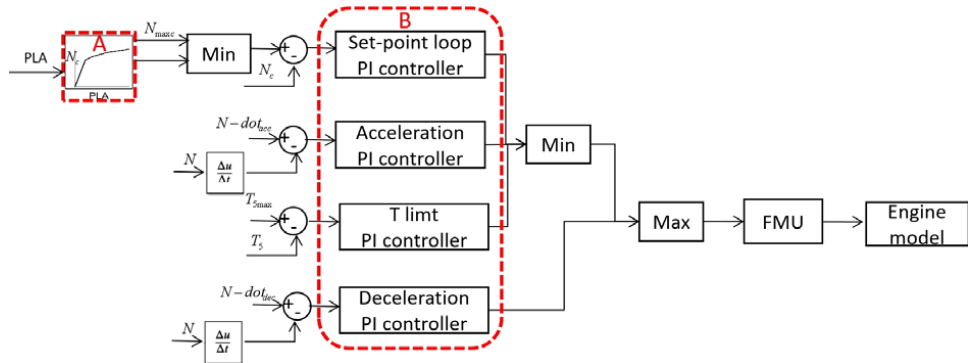
Figure 14 . Architecture of a Min ‐ Max controller. Figure 14. Architecture of a Min-Max controller.